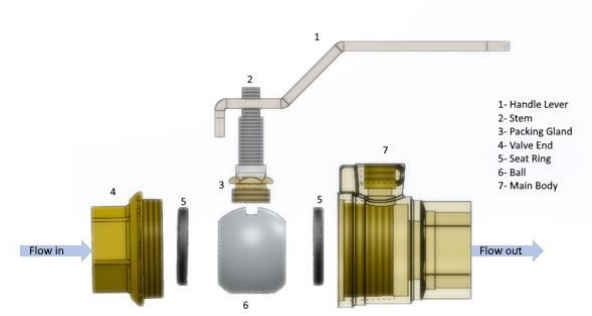
Figure 2: Structural model of ball control